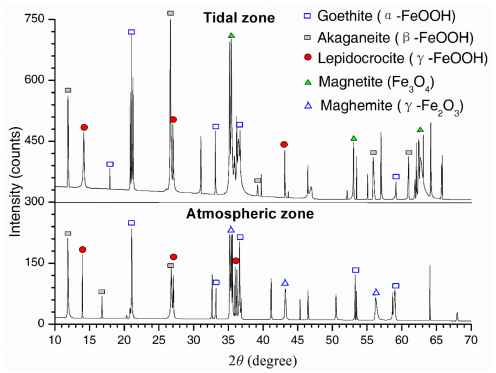
Figure 13. Peak profiles from XRD for rust samples in The atmospheric and tidal zones.